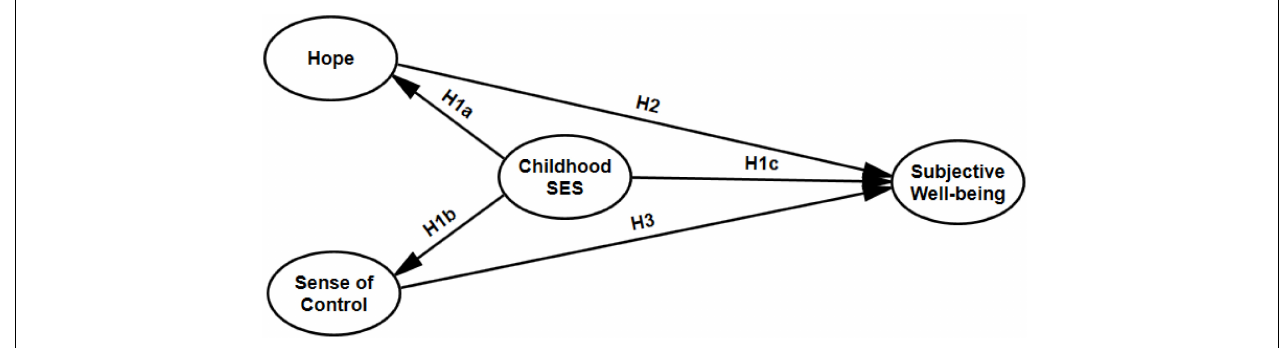
FIGURE 1 | The proposed structural relationships between childhood socioeconomic status, hope, sense of control and subjective